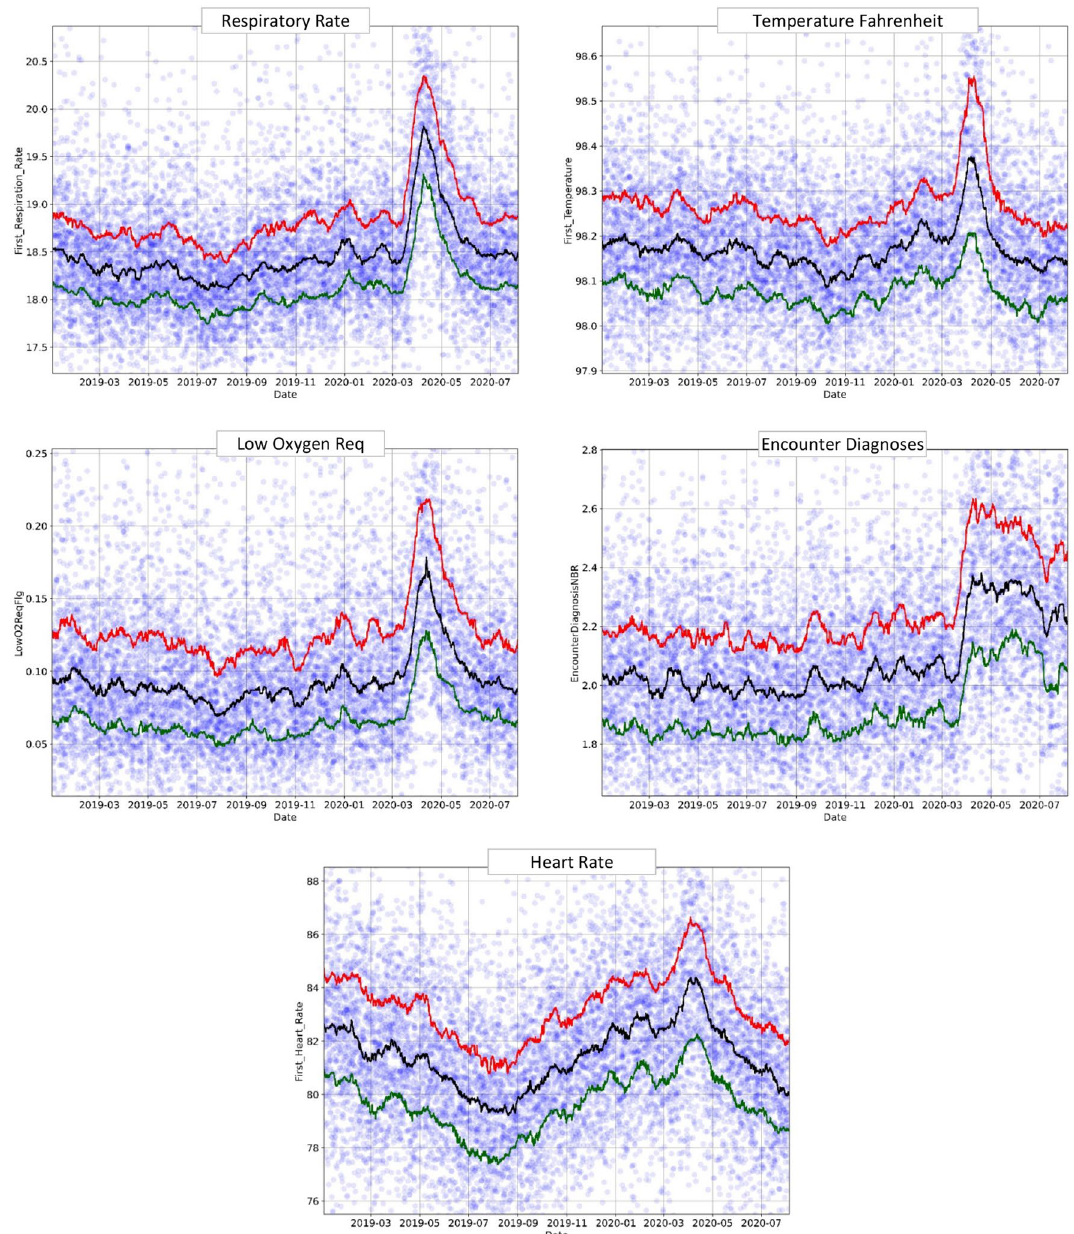
Figure 3. Respiratory rate, temperature, low O 2 requirement, number of diagnoses at first encounter, and heart rate model features plotted through time (January 2019–August 2020). The circles represent the original data averaged over 6-h intervals, and the lines-moving percentile curves for 25%, 50%, and